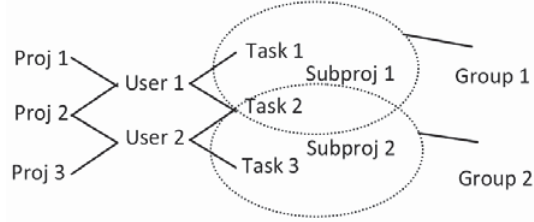
Fig. 5. Illustration of group of OSS developers co-working on some project tasks from the same group or two connect- ed